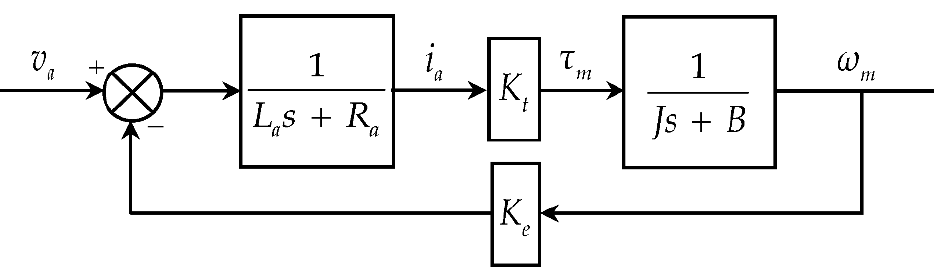
Figure 5. The block diagram of a brushed DC motor.